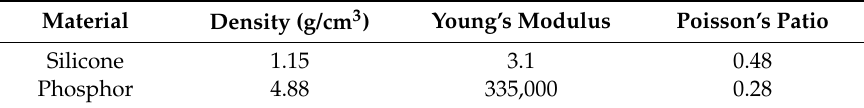
Table 1. Mechanical properties of the materials.